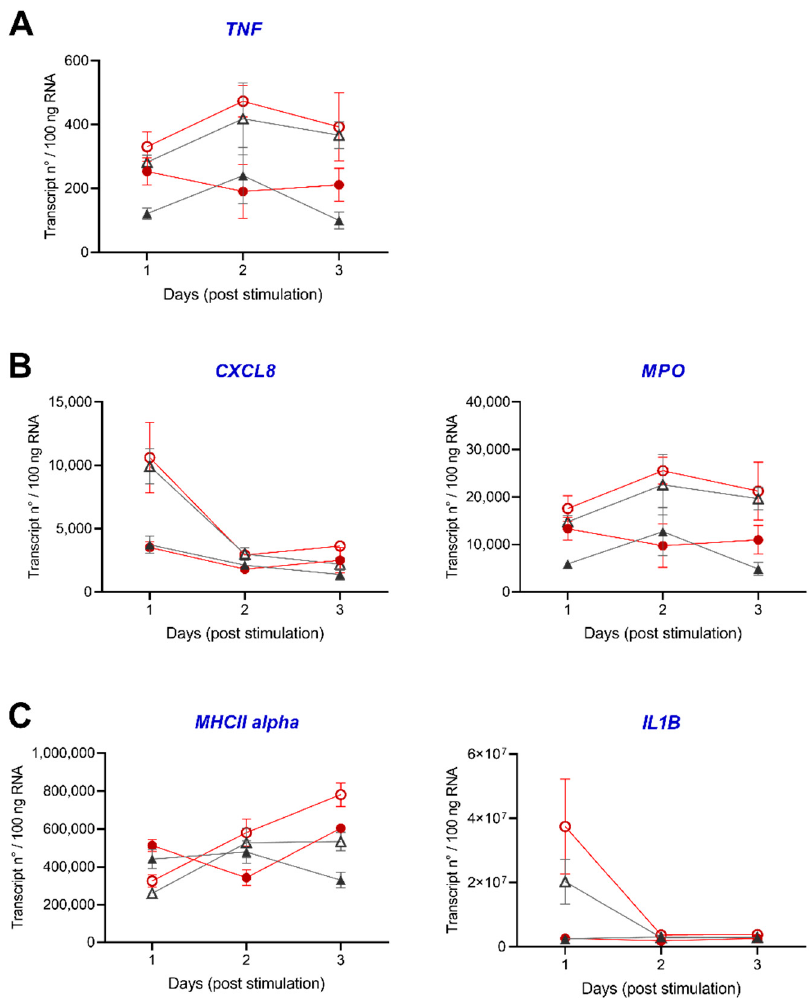
Figure 9. Expression of stress and immune markers in spleen of pikeperch upon acute peritoneal inflammation. Relative expression of candidate genes in spleen of pikeperch. Normoxic control group (grey), either unstimulated (grey/filled triangles) or stimulated (grey/empty triangles), and low DO groups, either unstimulated (red/filled circles) or stimulated (red/empty circles) after one, two and three days post intraperitoneal stimulation with inactivated Aeromonas hydrophila cells. Genes involved in stress (green) or immune response (blue) are either lowly ( A ), moderately ( B ) or highly ( C ) expressed. Data points represent mean of four individual samples (+SEM), calculated per 100 ng of total RNA. Statistically significant differences were calculated via one-way ANOVA followed by Tukey‘s multiple comparison test ( p = 0.05).